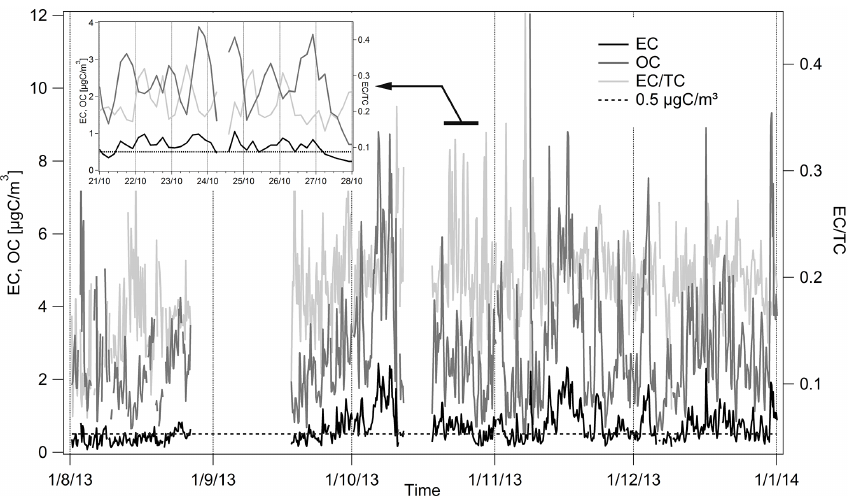
Figure 1. Time series of organic carbon (OC), elemental carbon (EC) and the ratio EC / TC where total carbon (TC) is sum of OC and EC. The limit of quantification for EC is depicted as a dashed line. The example time series for statistical investigation of censored observations is depicted in the small window.